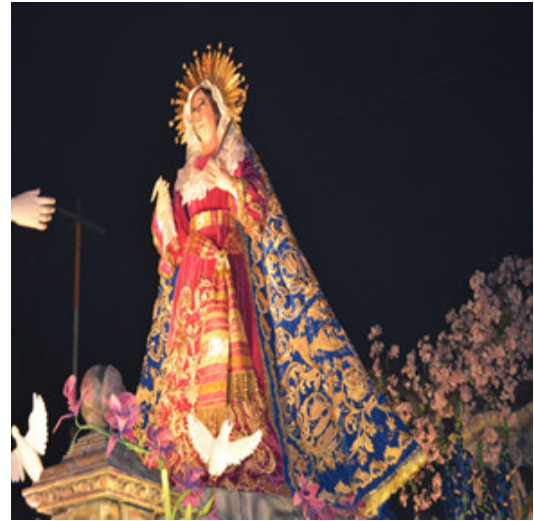
Figure 2. The Marian image in the procession of Saint Joseph.